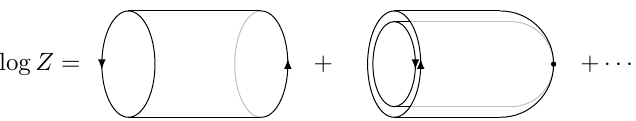
Figure 15 . The relevant connected diagrams for the free non-chiral string are cylinders that wind around entanglement time circle, and which collapse into an (cid:10)-point multiple times, each time re-emerging with the opposite